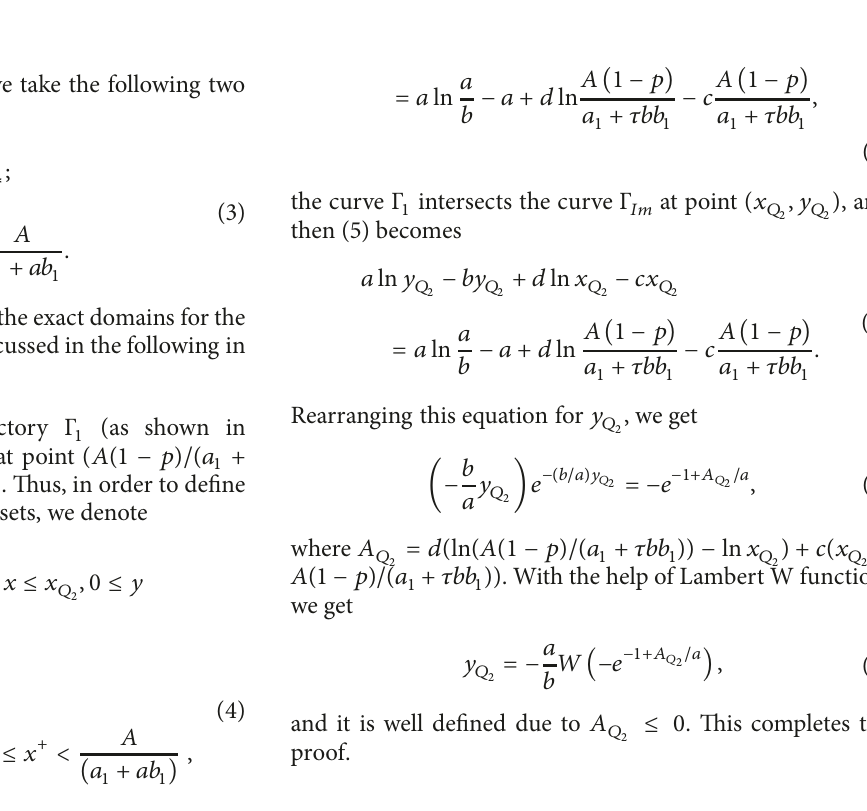
Γ 𝑇 = (𝑥 , 𝑦 ) , and Γ 𝑃ℎ at point 𝑇 𝑇 2 is a trajectory tangent to the curve